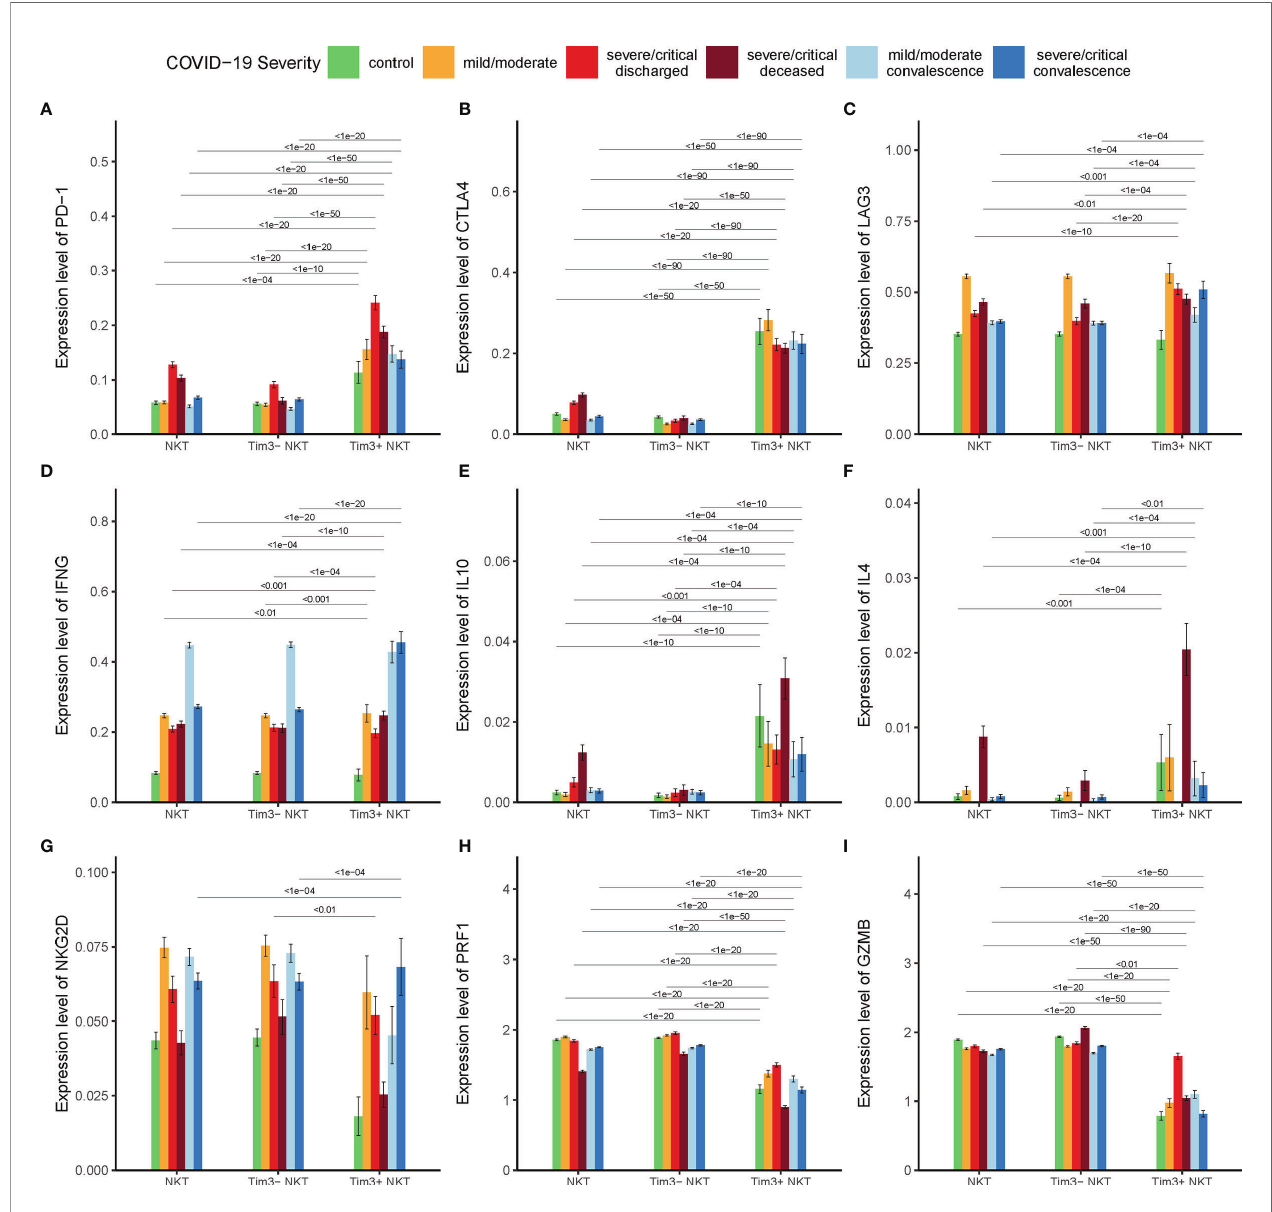
FIGURE 5 | Tim-3 expression and functional status of NKT cells in COVID-19. (A – C) Expressions of co-inhibitory receptor genes PD-1 , CTLA4 , and LAG3 on Tim-3+ NKT cells and Tim-3- NKT cells in COVID-19 patients and controls. (D – F) Expressions of cytokine genes IFN- g , IL-10 , and IL-4 on Tim-3+ NKT cells and Tim-3- NKT cells in COVID-19 patients and controls. (G – I) Expressions of cytotoxicity related genes NKG2D , PRF1 , and GZMB on Tim-3+ NKT cells and Tim-3- NKT cells in COVID-19 patients and controls. (Wilcoxon